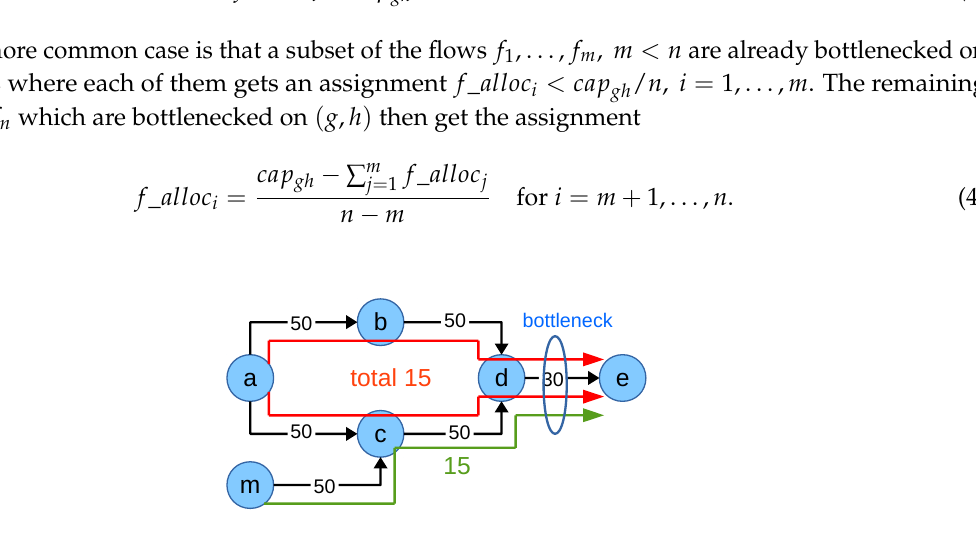
Figure 3. Example for bottleneck flow fair allocation. Blue circles: nodes; black arrows/numbers: links with capacities; colored arrows/numbers: flows with capacity assignments. All numerical values in